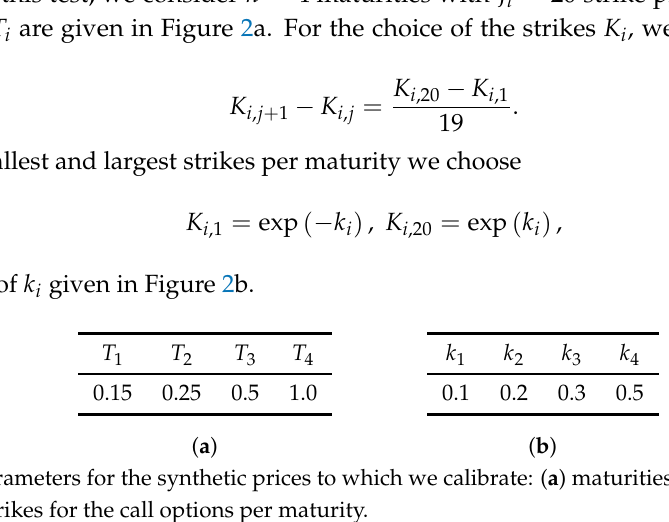
Figure 1. Implied volatility of the original parametric family (cid:101) a ξ ( a ) versus our modification a ξ ( b ) for maturity T = 0.5, the x -axis is given on log-moneyness ln ( K / S 0 ) .